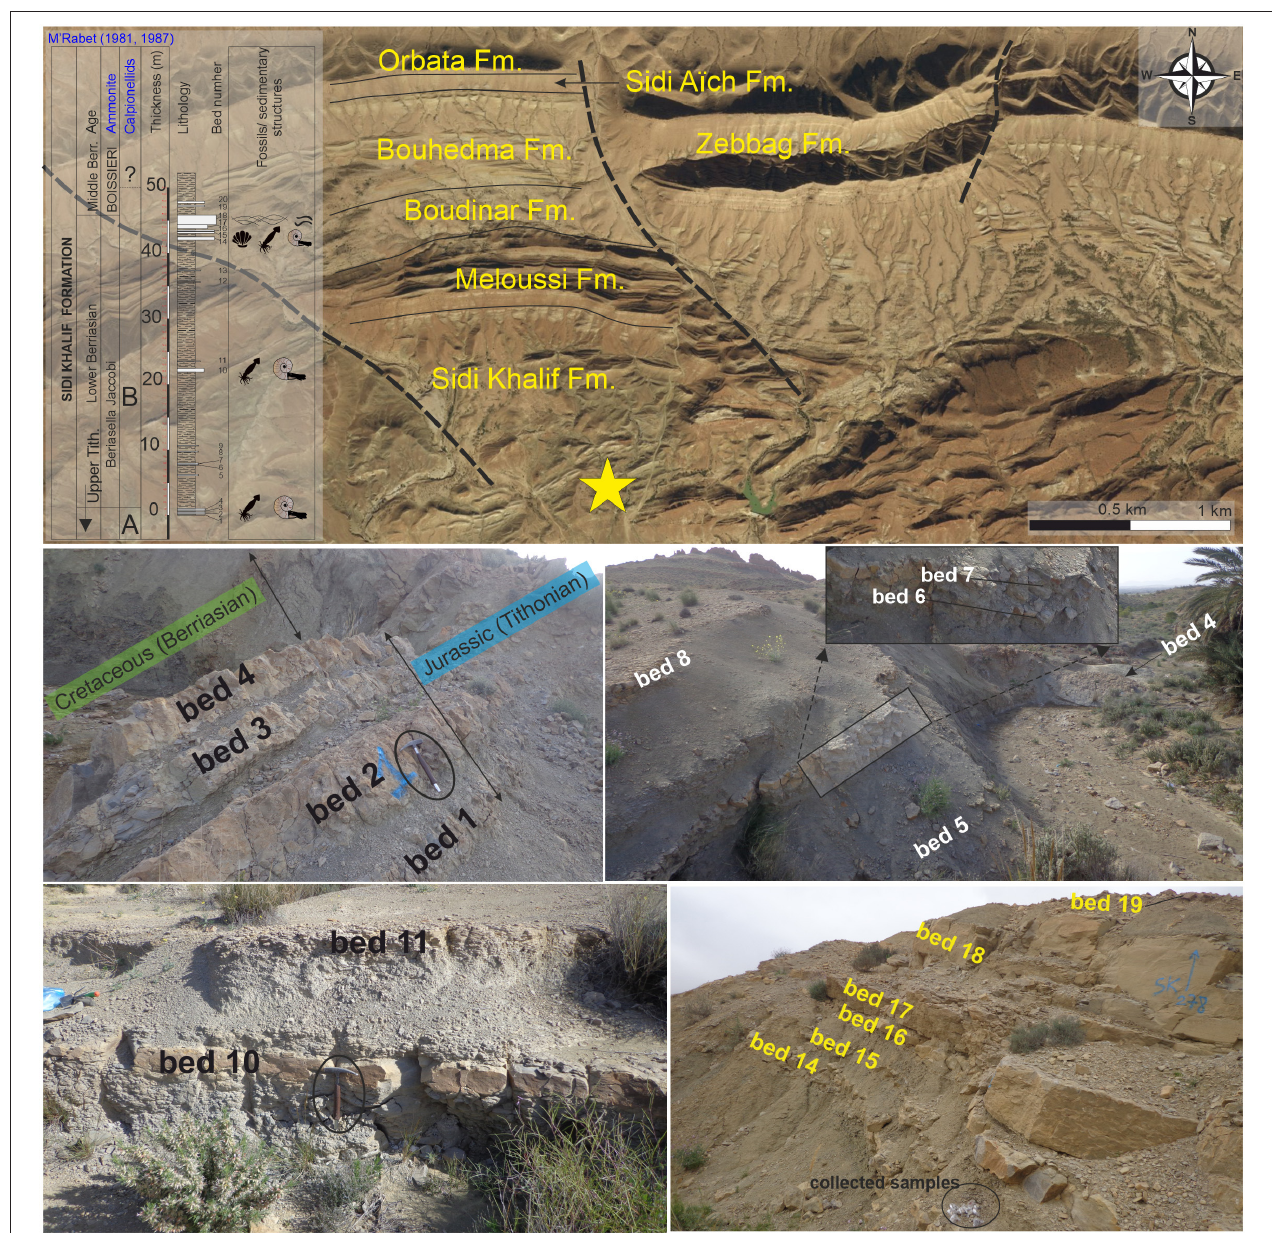
FIGURE 2 | Outcrop photos of beds 1 − 19 along the sedimentary succession of the studied interval. The top figure shows the outcropping Formations in the study area. The yellow star represents the location of the studied section.